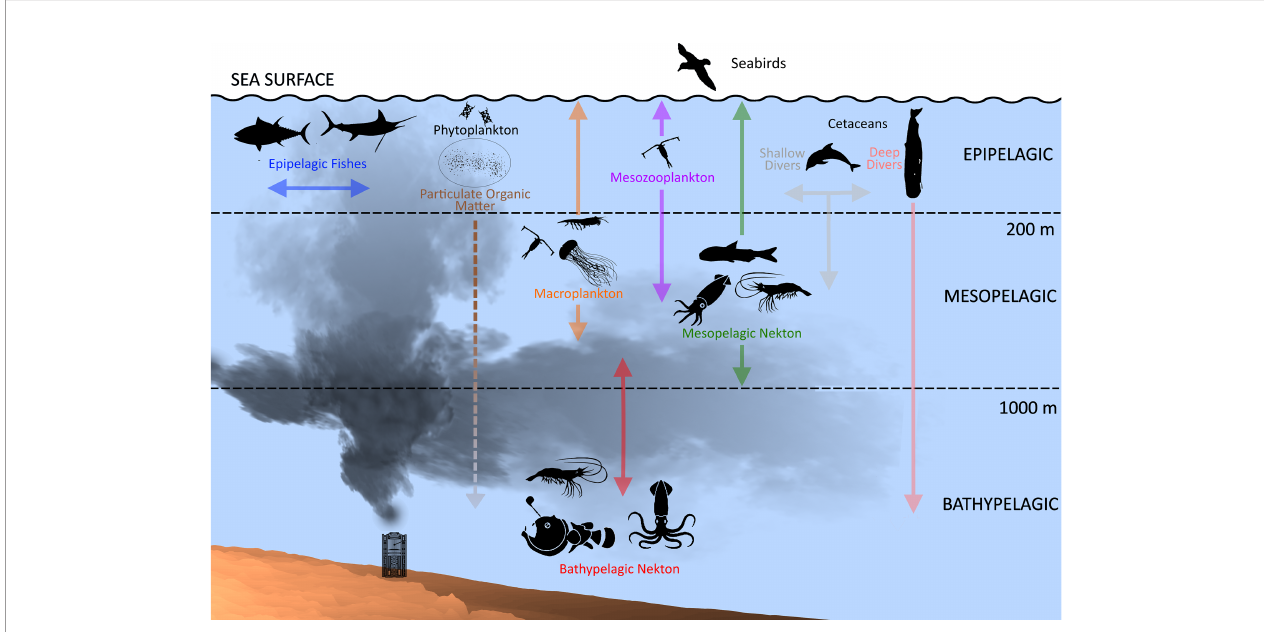
FIGURE 2 | Schematic of the open-ocean ecosystem of the northern Gulf of Mexico. Solid arrows associated with key taxa represent active fl ux (vertical migrations); dashed arrows indicate passive fl ux (sinking). Nekton = fi shes, cephalopods, and large pelagic crustaceans. Note: seabirds not treated in synthesis due to lack of time-series data but included here to represent aerial-to-deep-pelagic